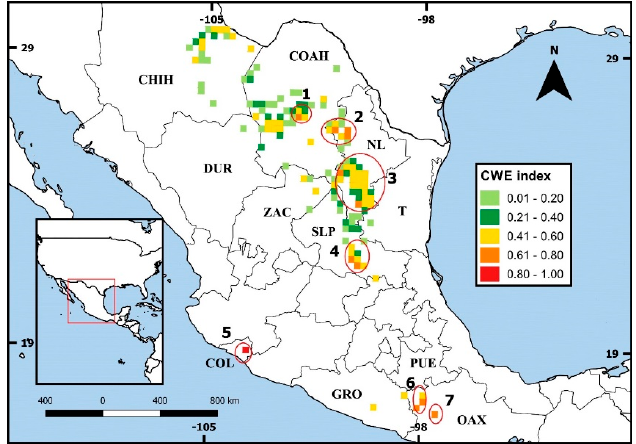
Figure 4. Centers of endemism detected for the gypsophytes in Mexico. Table 1. Restricted species that support the gypsophyte endemism centers. Supporting Species